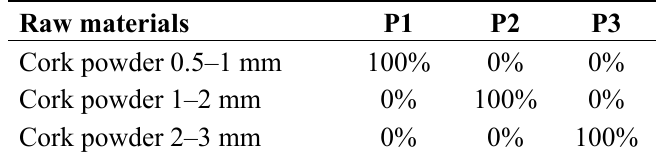
Table 1. Pelletizing (P1–P3) assays applied to raw